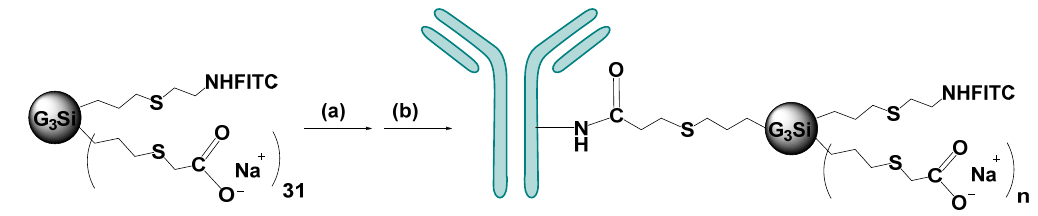
Figure 9. Conjugation between compound IV and infliximab. Formation of dendriplex IFX-IV (a) NHS, EDCI, MES (100 mM), 1 h; (b) infliximab, HEPES (100 mM), 24 h.